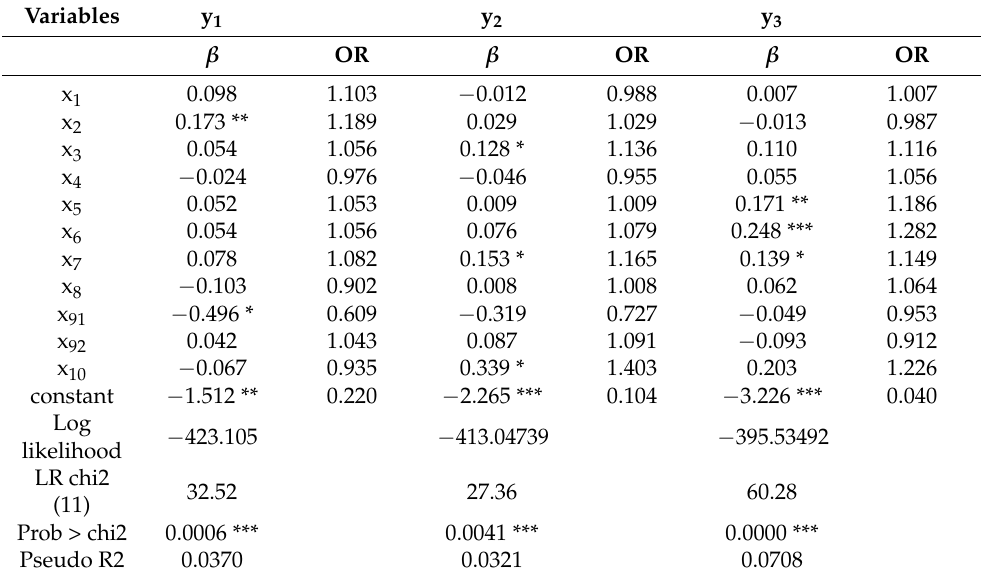
Table 3. Logistic regression for y 1 –y 3